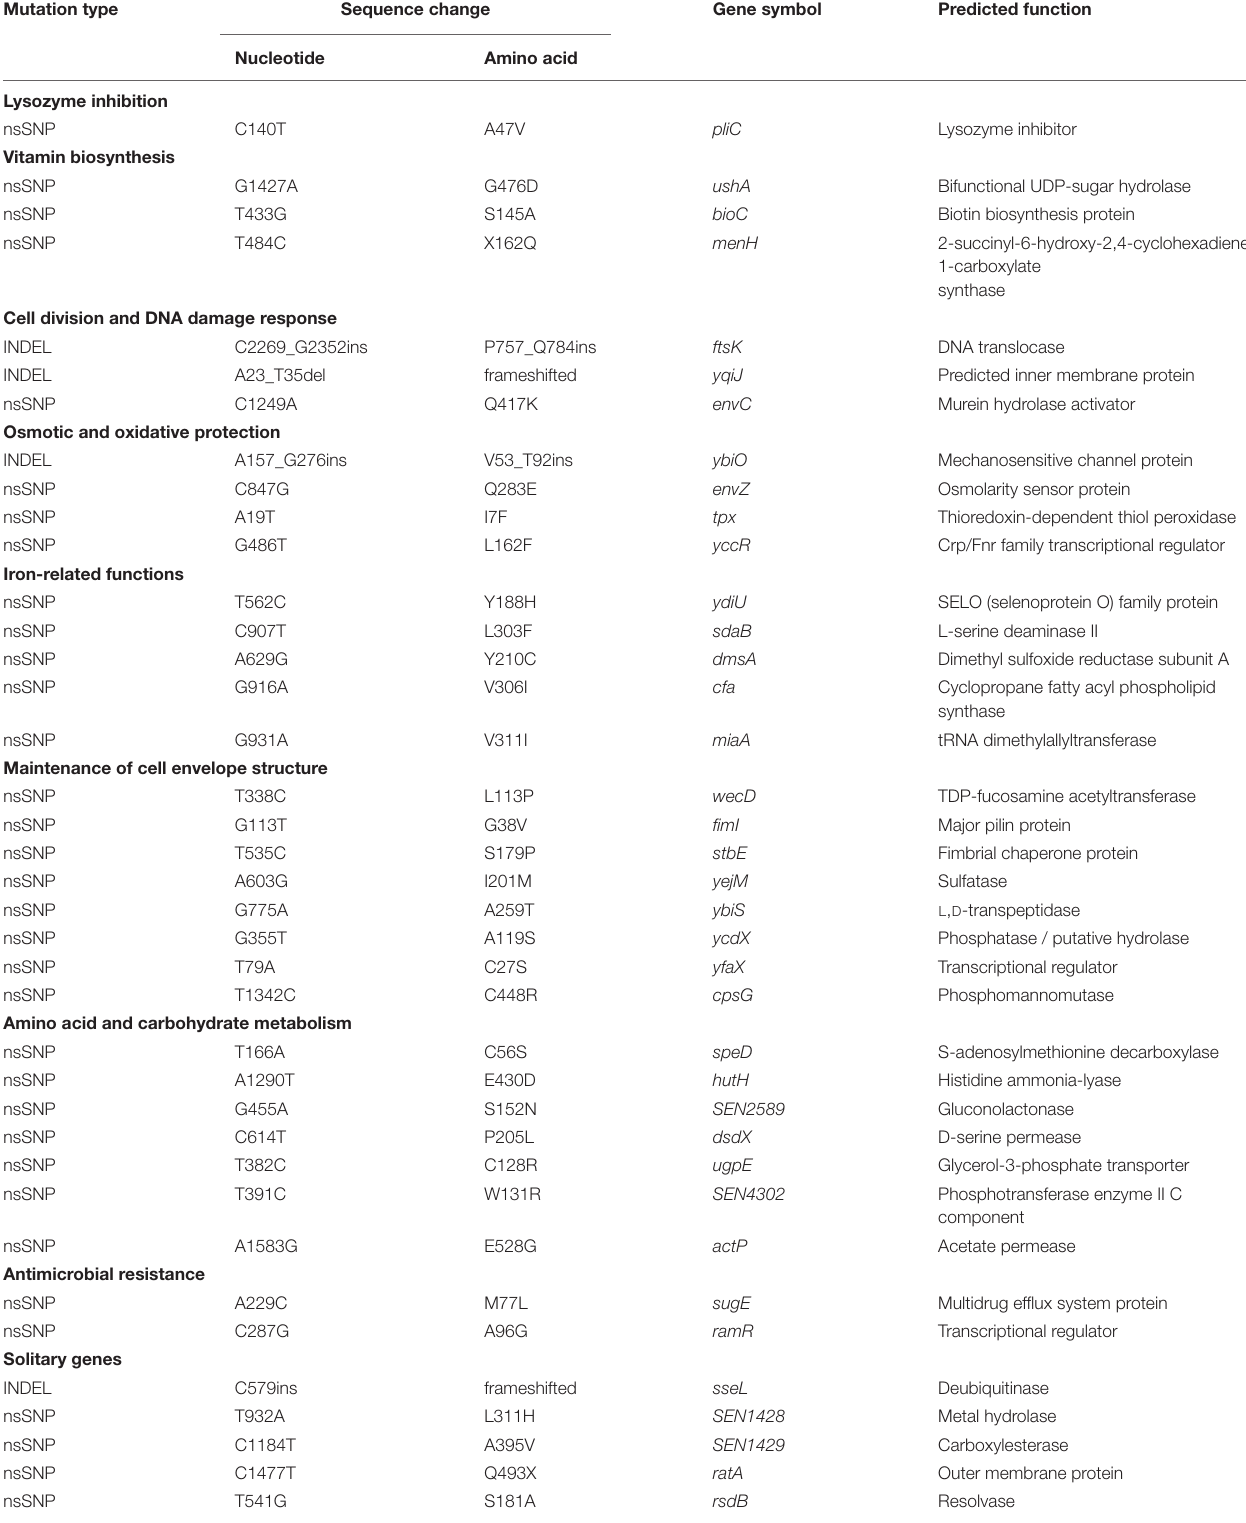
TABLE 2 | INDELs and nsSNPs in coding sequences between SJTUF10978 and SJTUF10984. Mutation